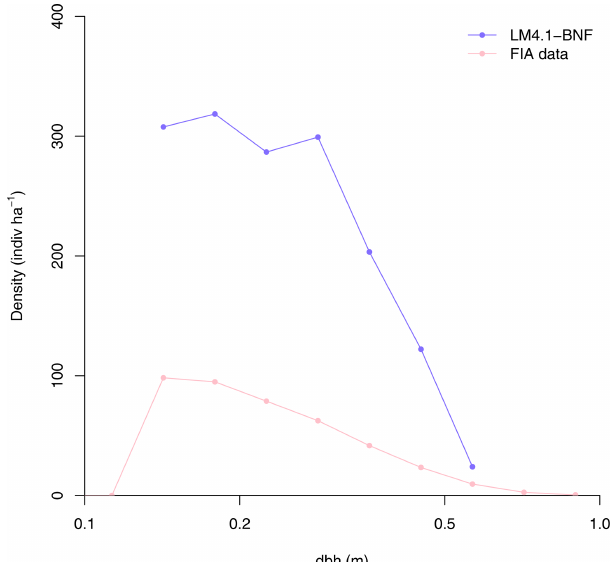
Figure D2. Simulated dbh distribution compared to FIA data (in North Carolina). Simulated data are trees with dbh > 12 . 7cm to reflect the dbh range of FIA data and are weighted by the stand age distribution of FIA data (Fig. D18). LM3-SNAP cannot distinguish between plant cohorts with different dbh’s or distinguish between Robinia and Acer